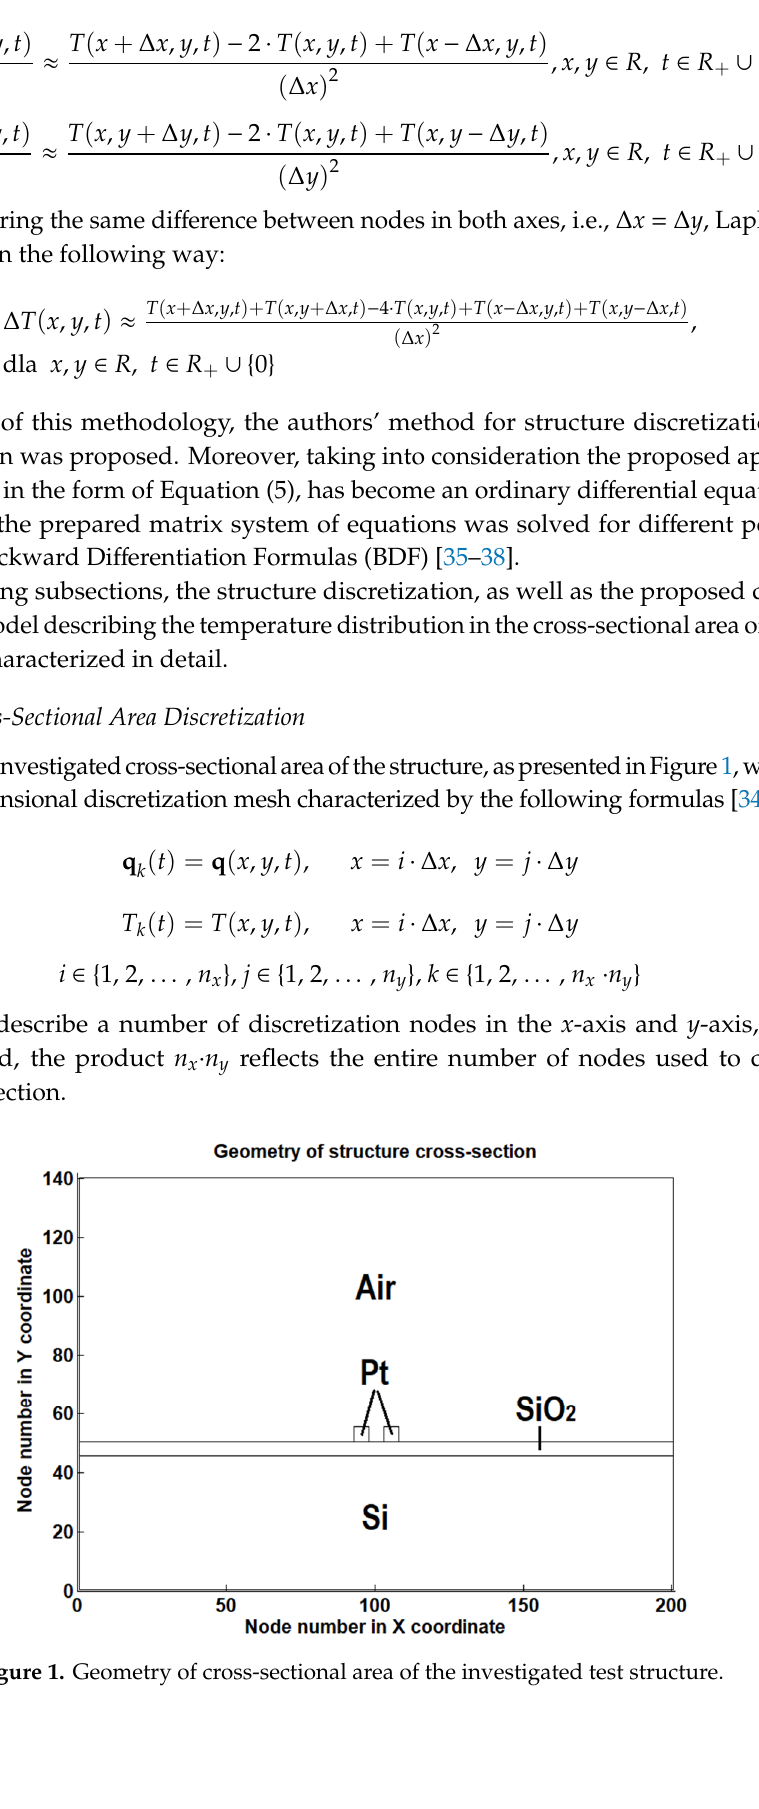
Figure 2. The graphical representation of discretization mesh and nodes’ numbering. Reprint with permission [34,39]; Copyright 2018, ŁTN 2.3. Dual-Phase-Lag Approximation Scheme for Test Structure In order to obtain the solution of temperature distribution problem inside the investigated cross- sectional area of the structure, the Dirichlet boundary conditions were considered at the bottom, while left, right and the top parts have been modeled using Neumann boundary conditions. Described situation can be characterized by the following equations: